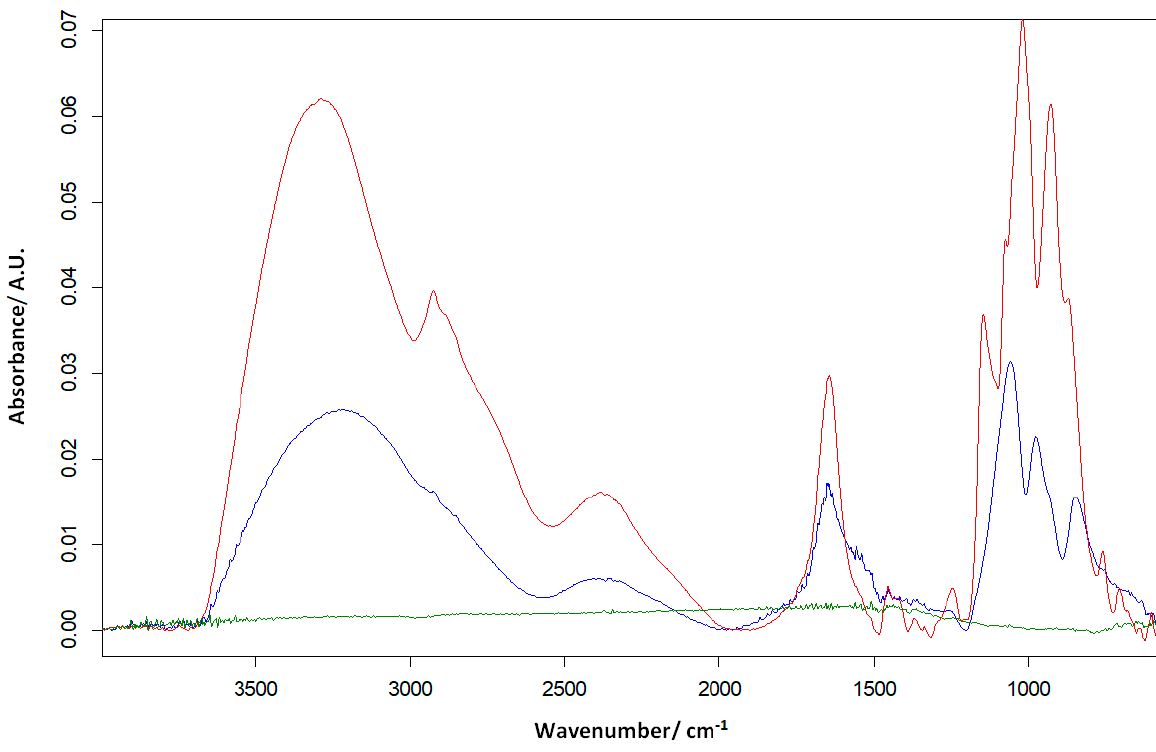
Figure 3. FTIR for SPE/SWCNT (green line), SPE/SWCNT/Tyr (blue line) and SPE/SWCNT/Lac (red line).